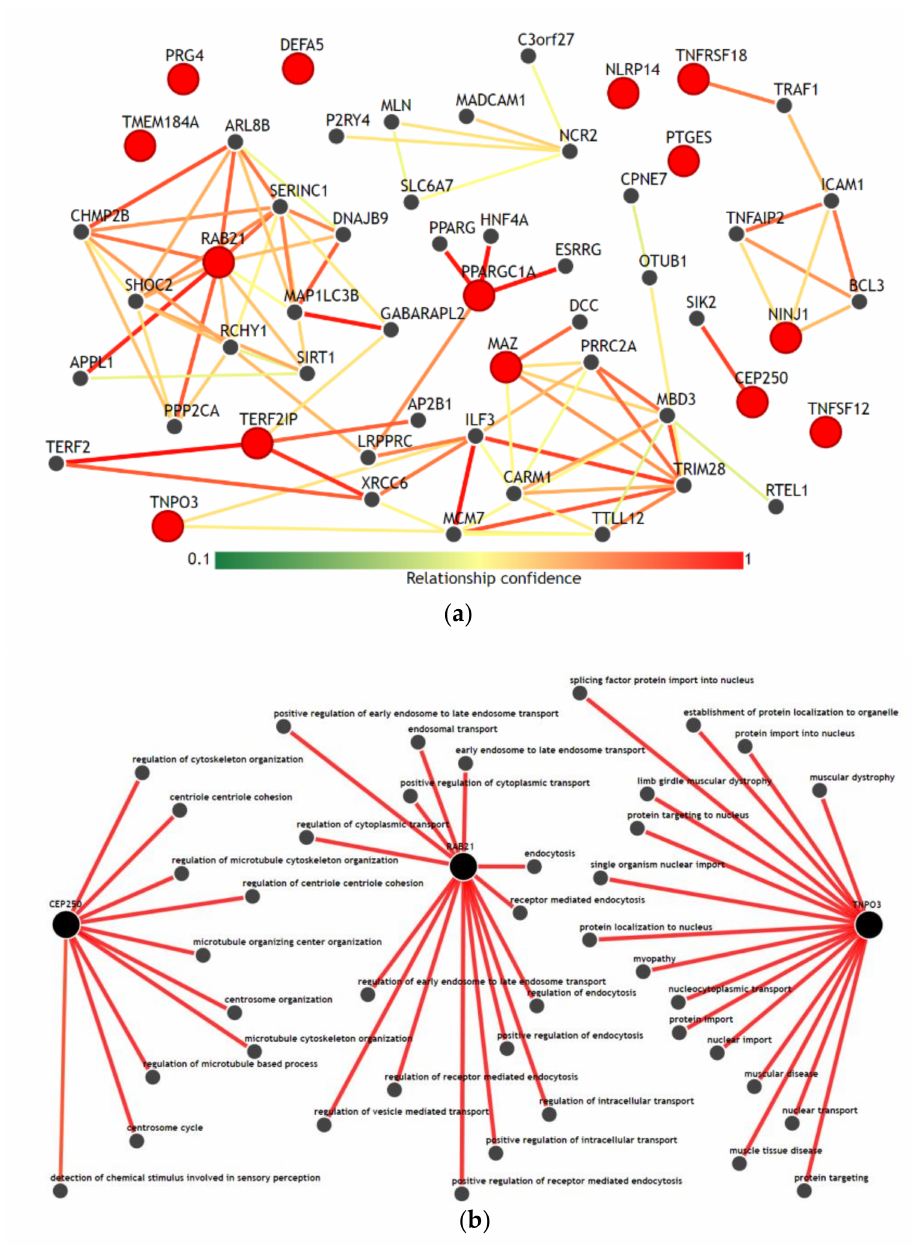
Figure 3. Functional network of the gene features used in the integrative model with clinical, gene expression and methylation features for the prediction of overall survival. ( a ) Gene-gene networks queried by 14 genes in the model. Red dots are the queried genes (14 genes, Table S1), and the black dots are the genes predicted based on functional networking analysis (0.5 confidence with 40